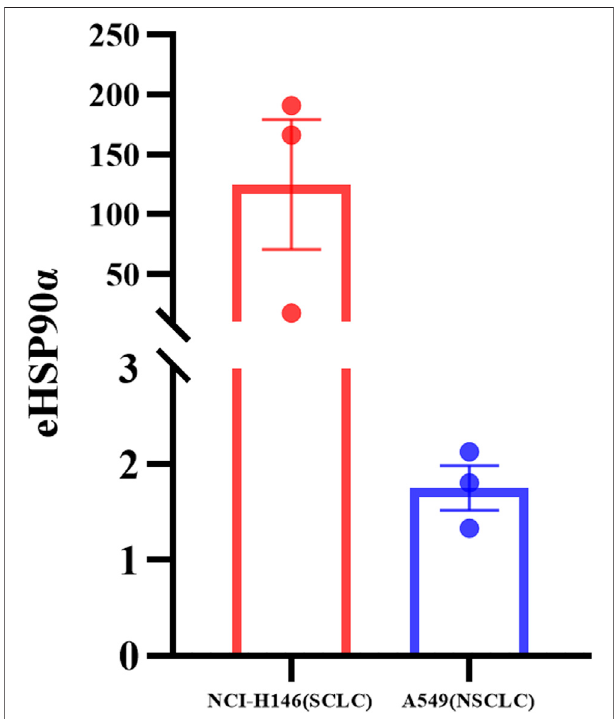
FIGURE7| DifferentialexpressionofeHSP90 α inSCLCandNSCLCcell lines.Theexpression ofeHSP90 α inNCI-H146 celllinesishigherthaninA549 cell lines ( n =